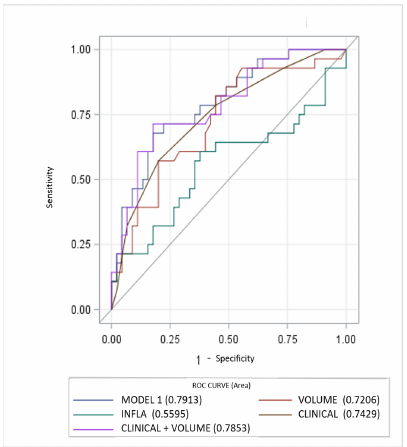
Figure 1. Performance of clinical, inflammatory and CT parameters (single and composite) for risk prediction of ventilator assistance and or death. CT measurements of lung involvement (VOLUME) add incremental predictive value to model including only clinical parameters (CLINICAL) and beyond a model only including laboratory features (INFLA).